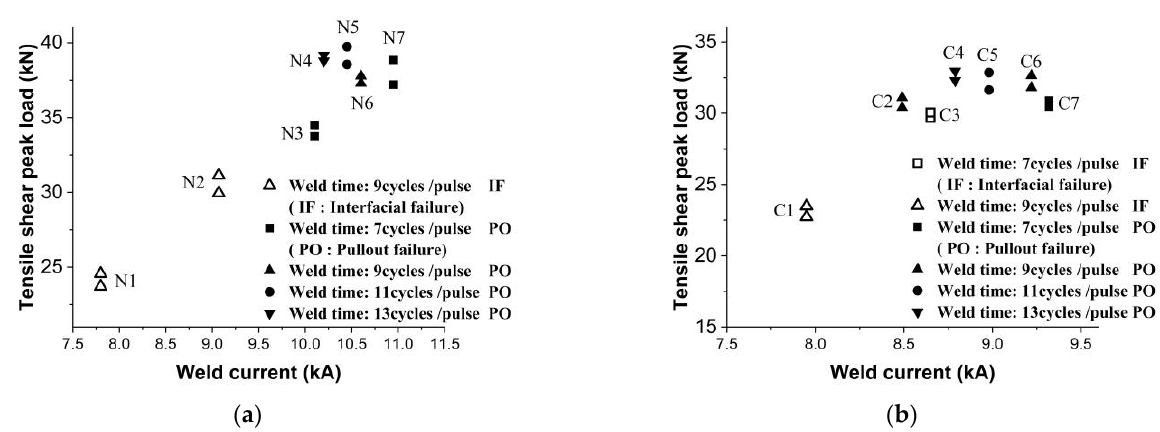
Figure 7. Tensile shear failure loads of welded joint for ( a ) uncoated hot-stamped Usibor1500 and ( b ) Al-Si coated hot- stamped Usibor1500.